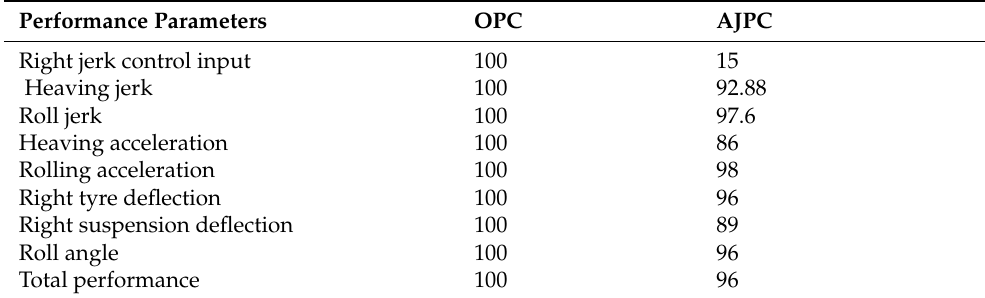
Table 3. Root mean square error (RMSE) values of performance parameters of half car subjected to an asphalt